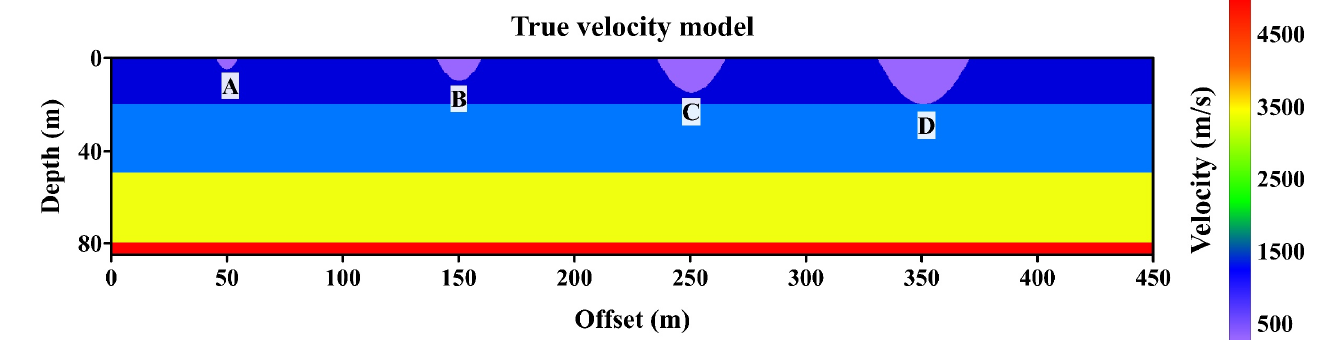
Figure 7. The synthetic velocity model used in the simulation test. A, B, C, and D are the four local anomalies added to the 1D homogenous velocity model. Table 1. Velocity and thickness values of the synthetic model. Layer No.